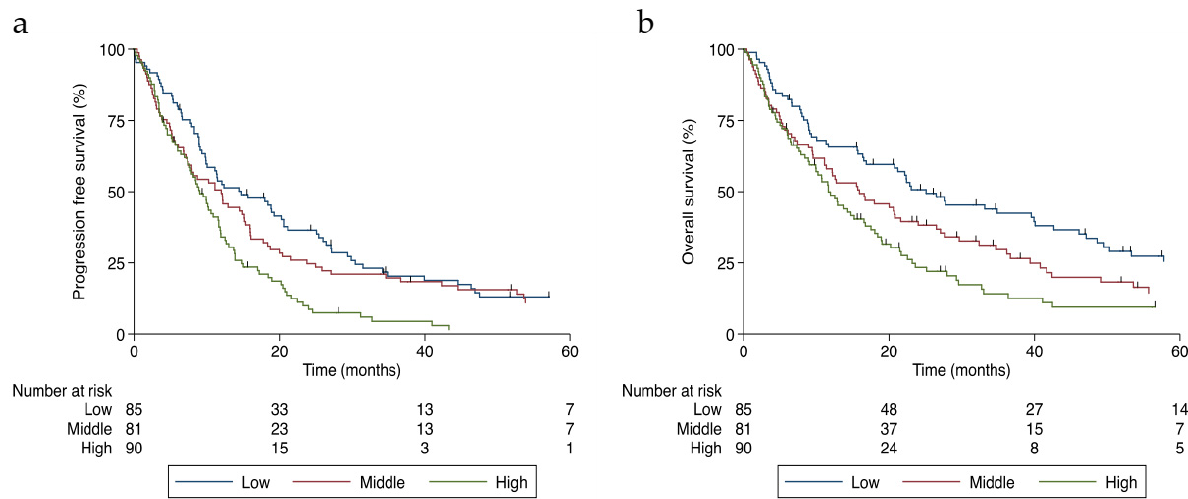
Figure 2. Survival curves of patients with stage IV or recurrent colorectal cancer divided by corrected calcium tertiles (in mg/dL): ( a ) progression-free survival and ( b ) overall survival .